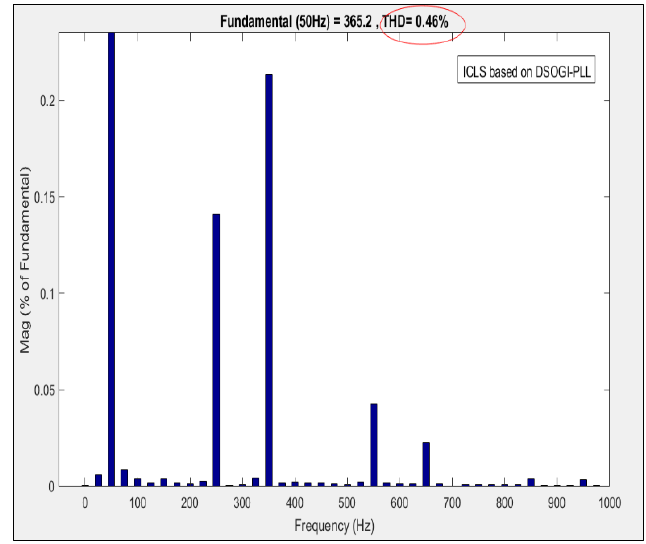
Figure 10. The THD case study 1 performance results with ICLS-DSOGI-PLL.